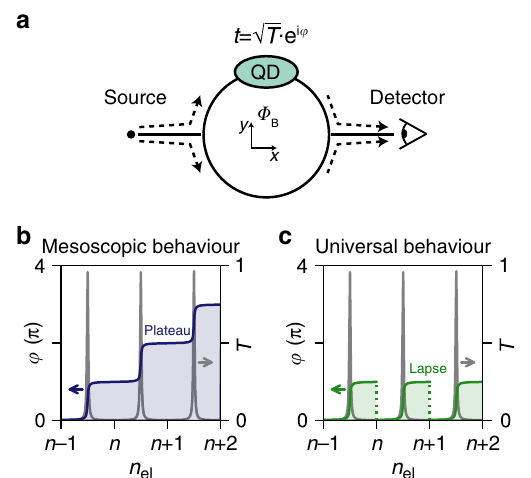
Fig. 1 Mesoscopic and universal phase behaviours. a The minimum setup to study the transmission phase via a quantum dot (in light green) is a two- path interferometer. b , c Transmission phase φ and probability T as a function of the electron number n el in a quantum dot. A Breit – Wigner function describes each of the resonances (in grey). b The mesoscopic regime: phase plateaus in the Coulomb valleys appear at 0 and π . c The universal regime: phase lapses occur between transmission resonances.